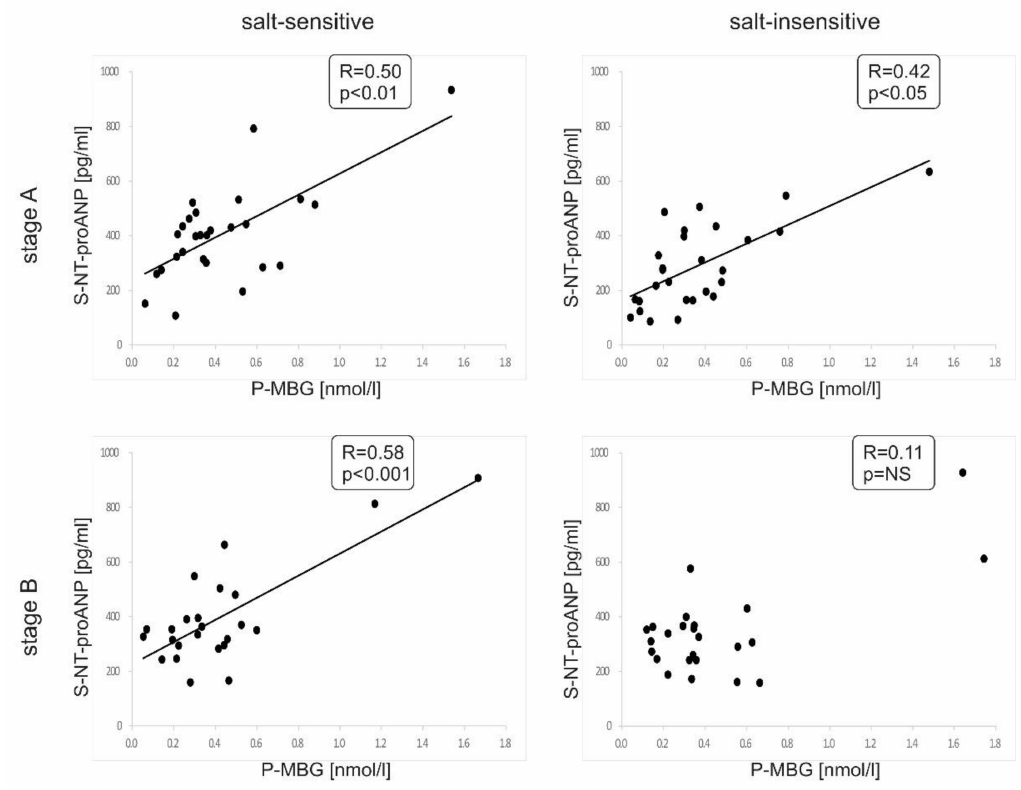
Figure 3. Correlation between plasma MBG and serum NT-pro ANP concentrations at baseline (stage A; upper panels) and after sodium restriction (stage B; lower panels) in salt-sensitive and salt-insensitive groups,